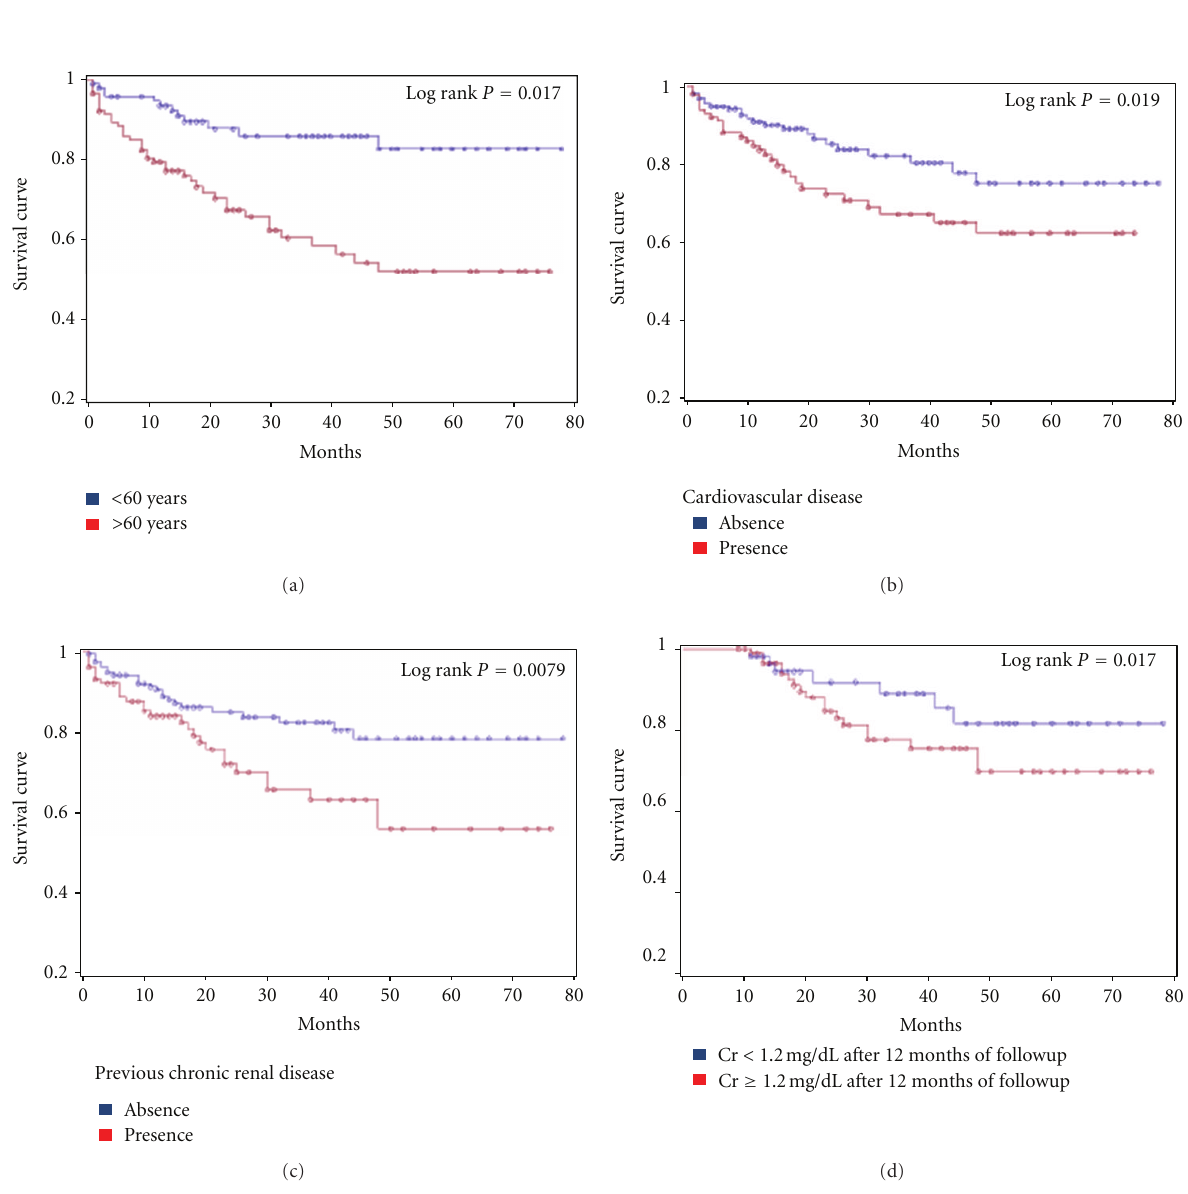
Table 4: Multivariate analysis of risk factors associated with late mortality of patients after an episode of acute tubular necrosis. Variable HR IC 95% P